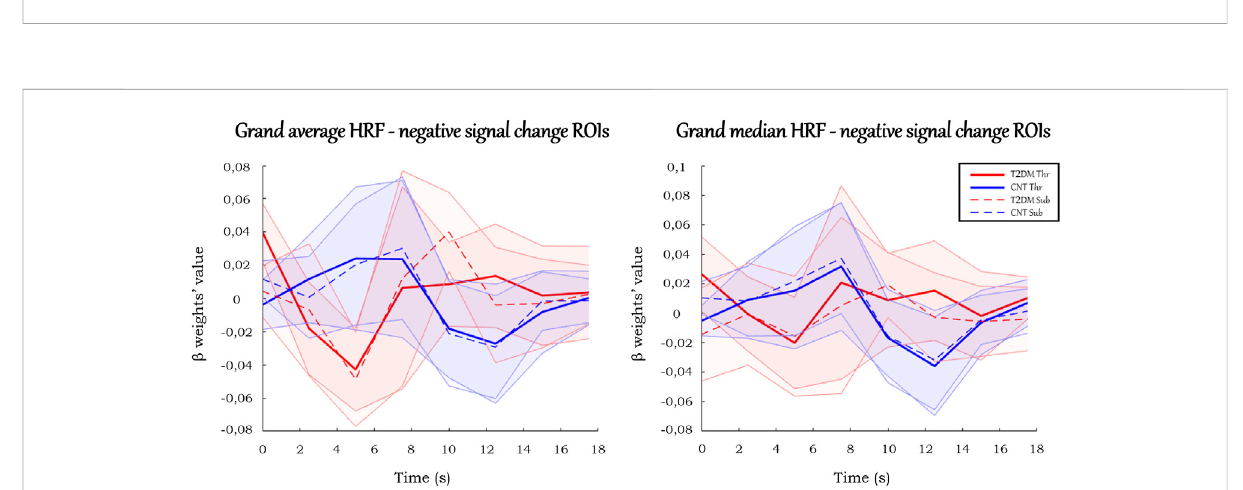
FIGURE 5 Average HRF curves in each ROI with positive signal change. Solid and dashed thick lines represent the average for each condition, and the shaded areas represent the standard deviation.